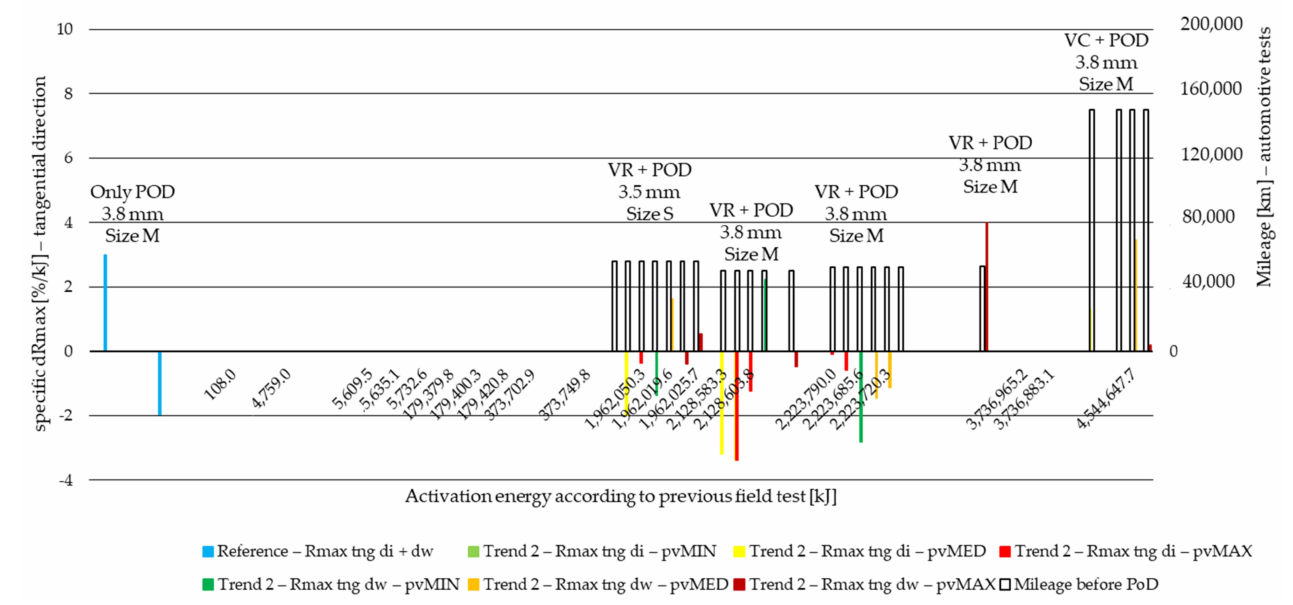
Figure A8. Tangential direction PoD specific Rmax difference values of cut material samples from inner and working diameter after minimum, medium and maximum pv level pin-on-disc tests with previous field-test (Table 2) mileage along Joule scale—Trend 2: moderate load